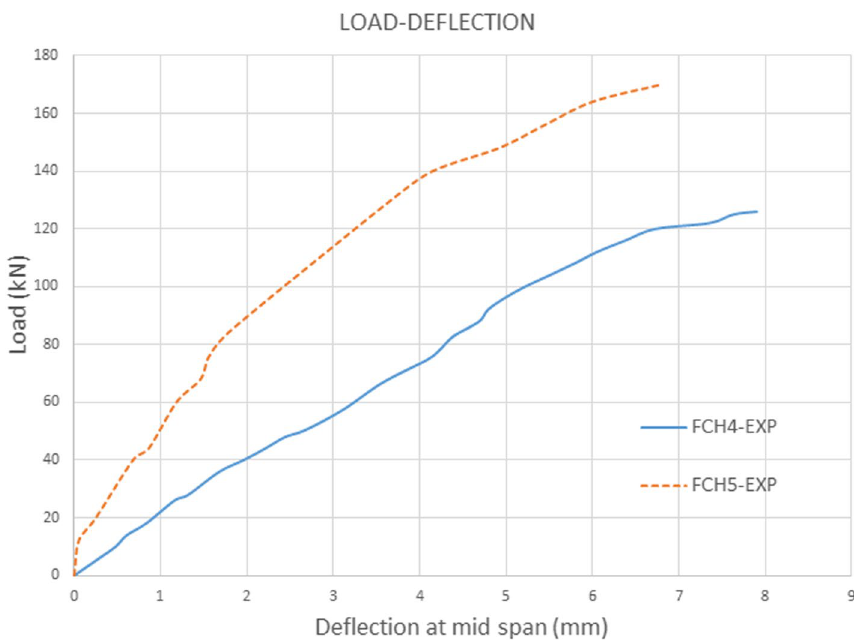
Fig. 19 Load vs. mid-span deflection curves for FCH4 and